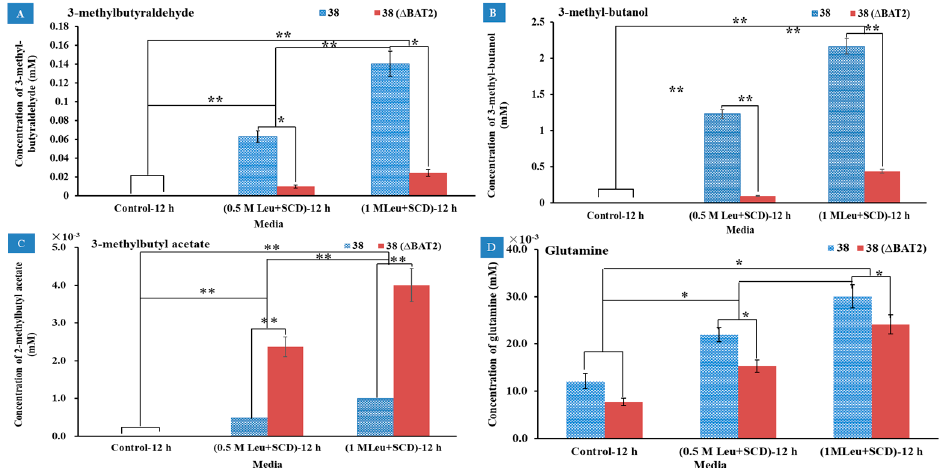
Figure 4. The effects of Leu addition amount in media and BAT2 gene deletion on the metabolites. ( A ) The effects of Leu addition amount in media and BAT2 gene deletion on the yields of 3-methyl-butyraldehyde; ( B ) the effects of Leu addition amount in media and BAT2 gene deletion on the yields of 3-methyl-1-butanol; ( C ) the effects of Leu addition amount in media and BAT2 gene deletion on the yields of 3-methylbutyl acetate; ( D ) the effects of Leu addition amount in media and BAT2 gene deletion on the yields of glutamine. ** Extremely significant ( p < 0.01, n = 3); * significant ( p < 0.05, n = 3).